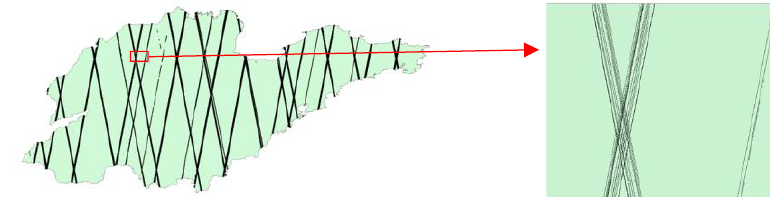
Figure 2. Laser point data distribution and local magnification in the experimental